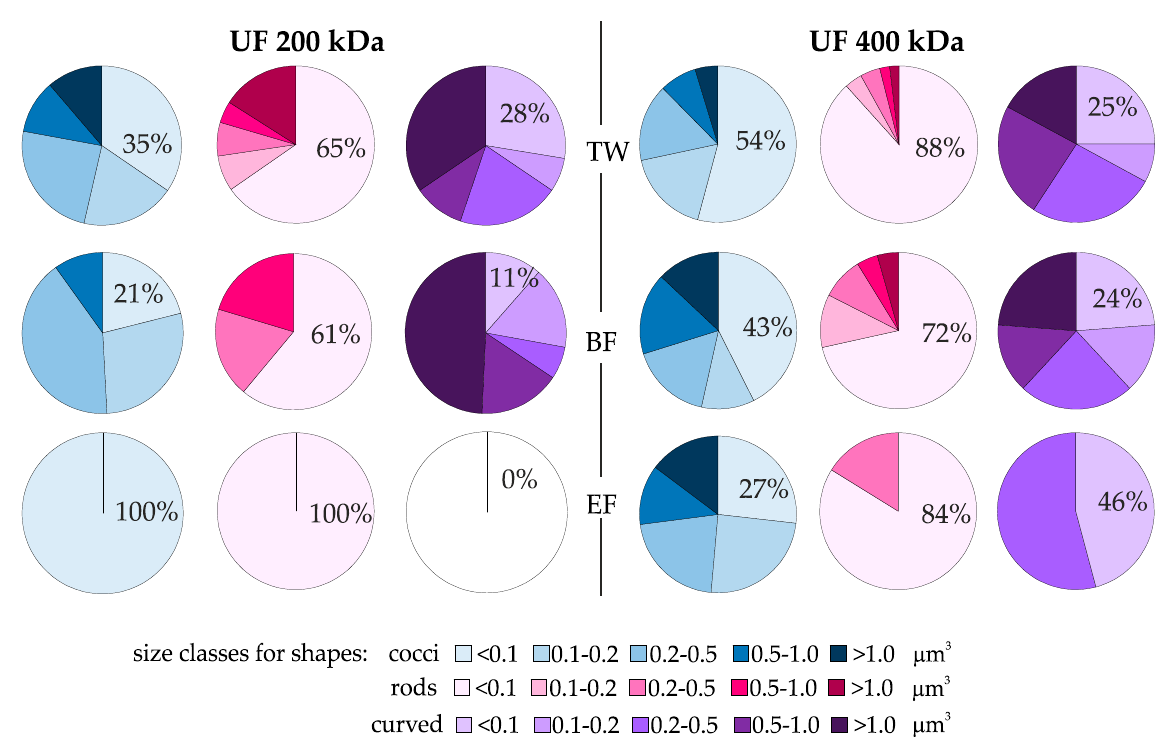
Figure 7. Comparison of the percentage share of cocci, rods and curved, with respect to five bio-volume classes in treated wastewater (TW) subjected to membrane filtration with the use of ultrafiltration membranes with separation of 200 kDa and 400 kDa at the beginning of the filtration cycle (BF) and at the end of the filtration cycle (EF).